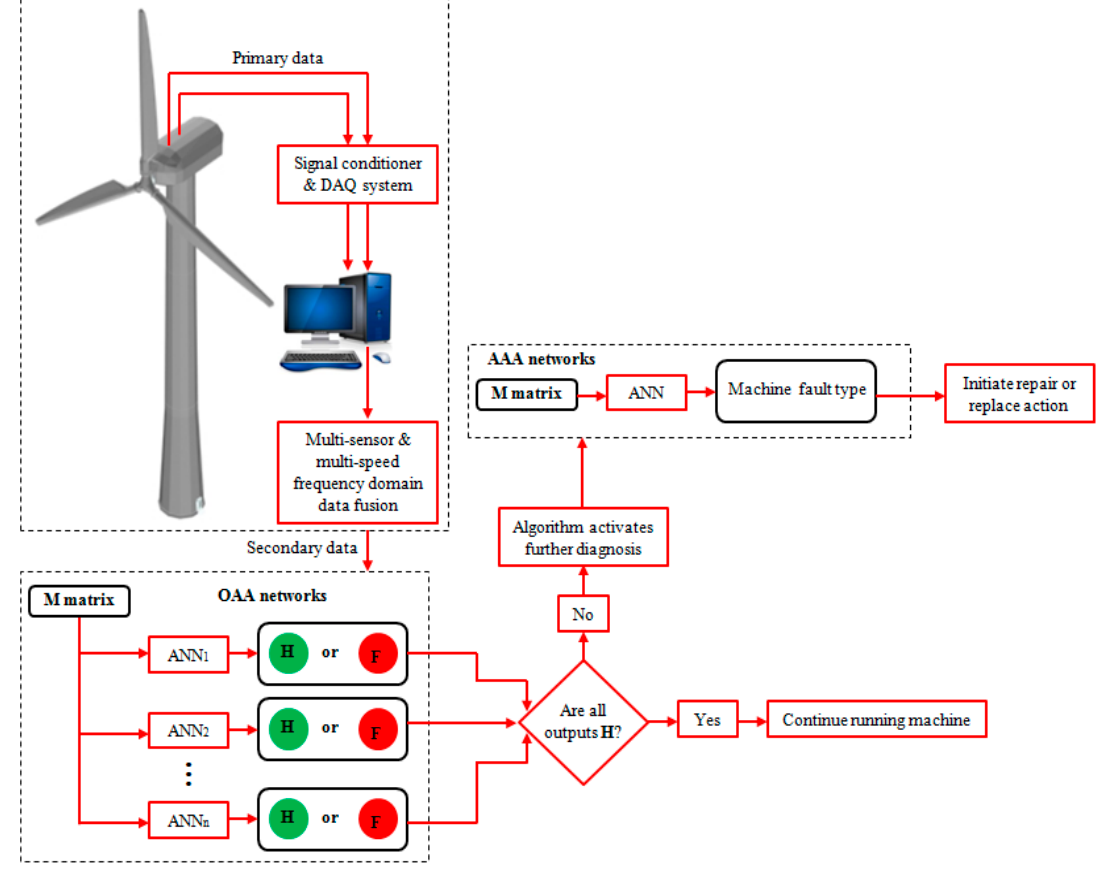
Figure 4. Proposed fault diagnosis algorithm flowchart.